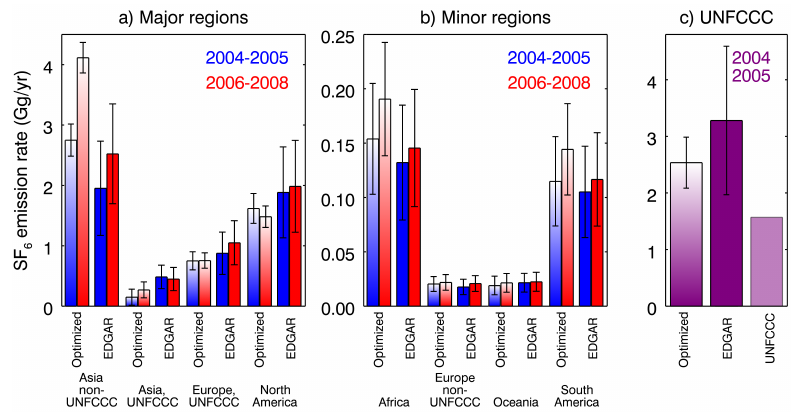
Fig. 4. Regional SF 6 emission rates and 1- σ uncertainty range for 2004–2005 (blue) and 2006–2008 (red) from (a) Major emissions regions, and (b) minor regions. Optimized values are shown as shaded bars, whilst EDGAR estimates are solid colors. (c) Aggregated optimized, EDGAR and UNFCCC-reported emissions for reporting countries only.